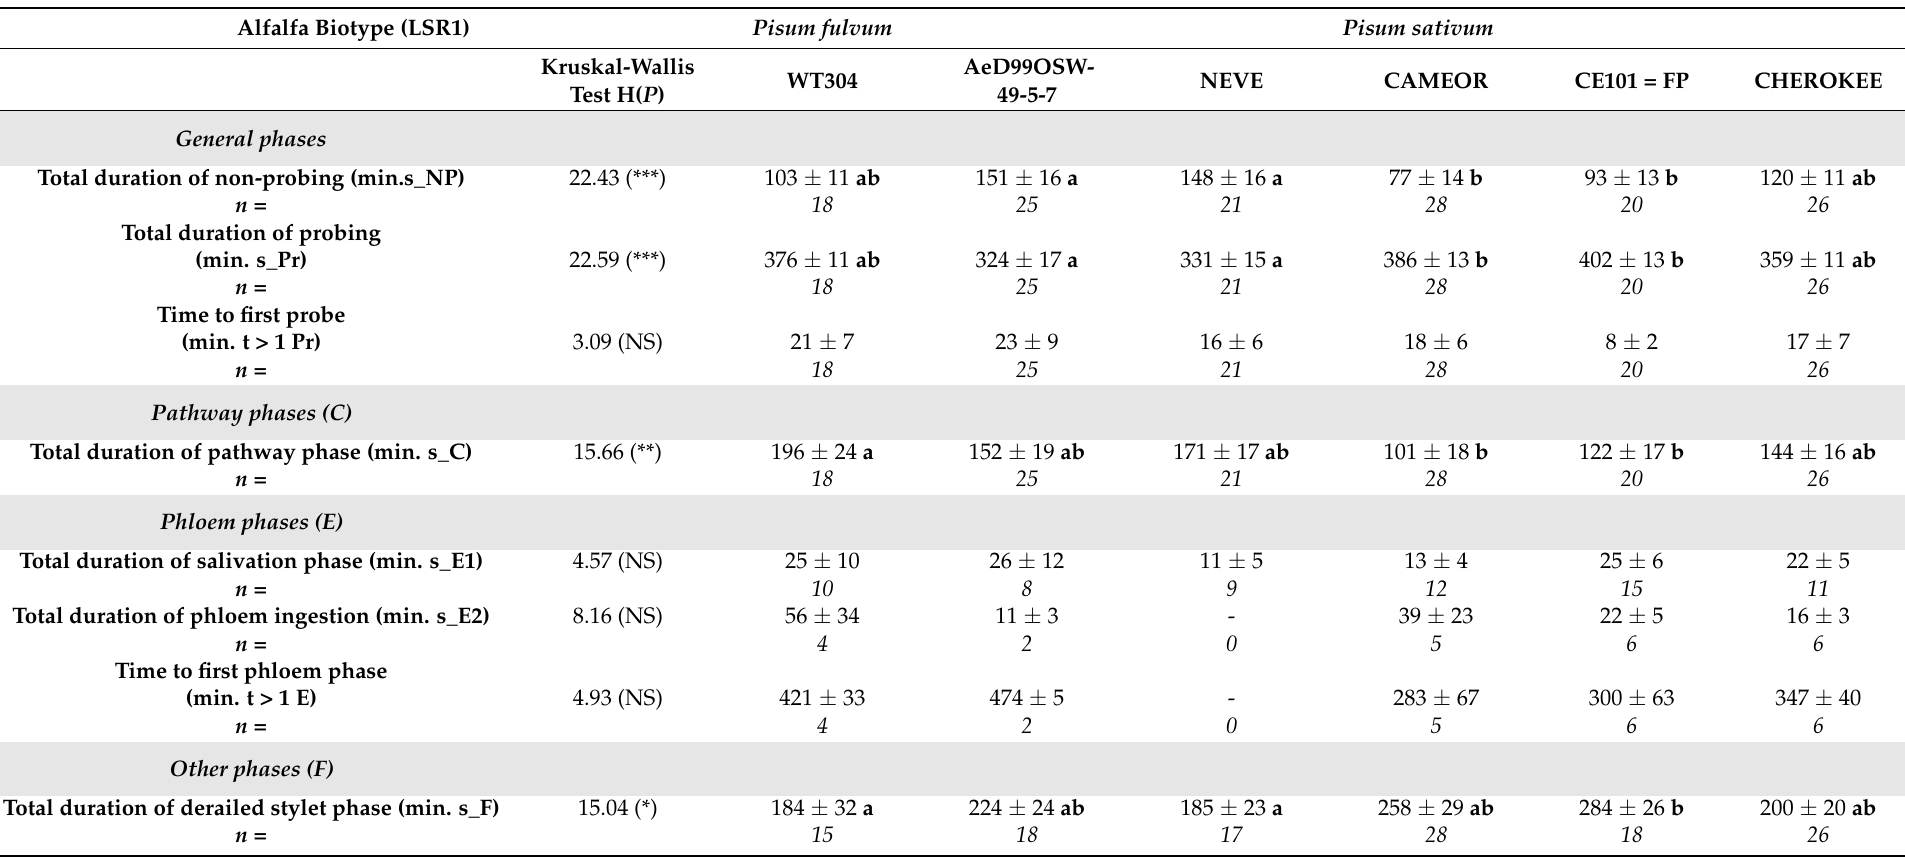
Table 2. Electrical penetration graph parameters (means ± SEM) calculated for A. pisum alfalfa biotype (LSR1 clone) during an 8 h monitoring session on different genotypes of P. sativum and on P. fulvum